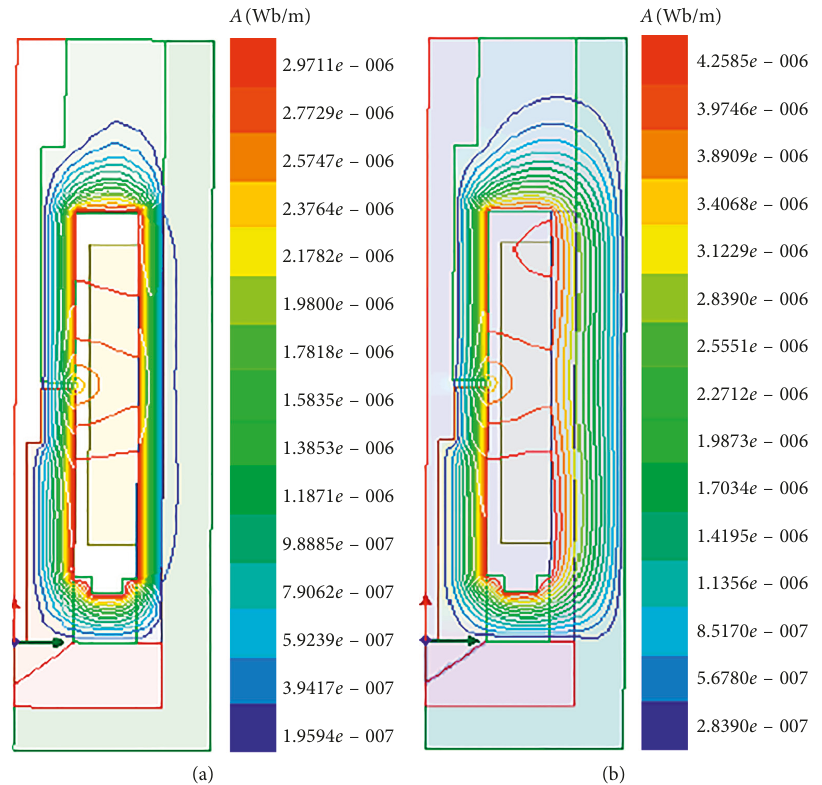
Figure 8: Distribution of magnetic lines of force. (a) 0.8A. (b) 1.2A.